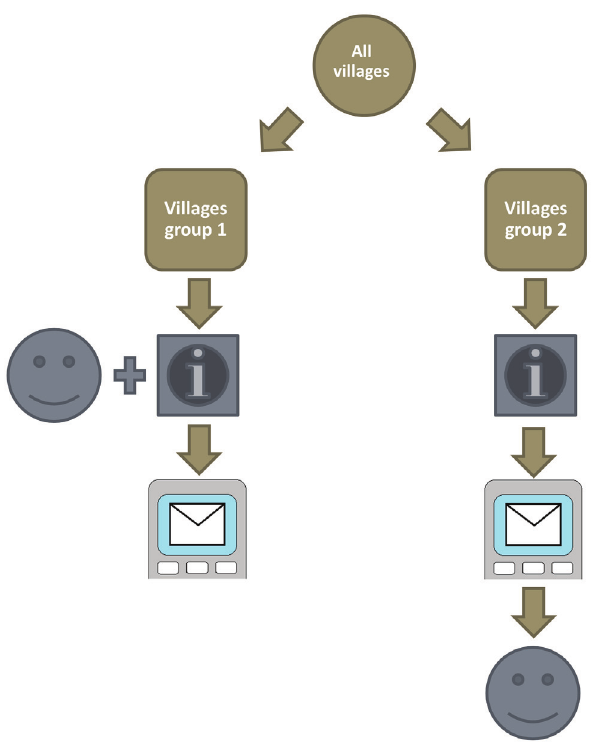
Figure 3. Design of randomised cross–over study. Letter clipart indicates informed consent and collection of demographic and mobile phone use information; face clipart indicates interview- er–administered face–to–face survey on childhood